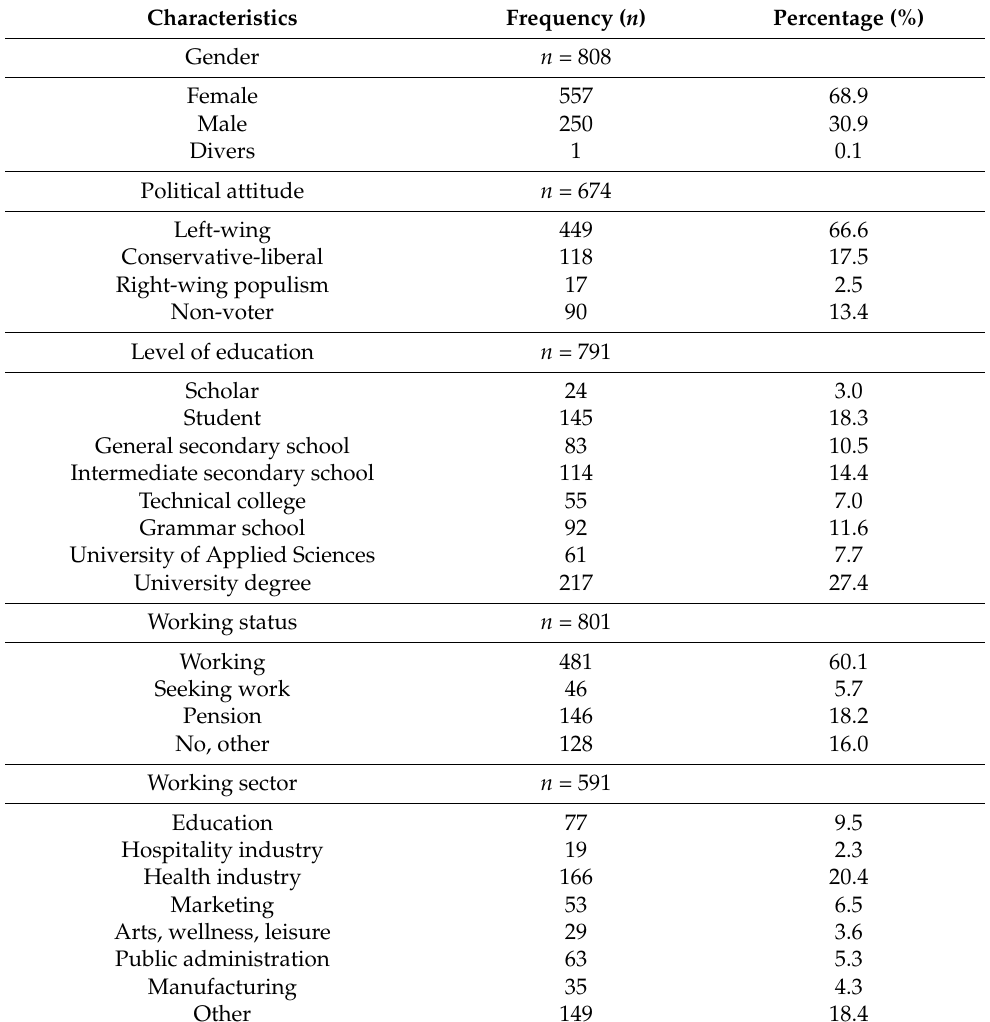
Table 1. Demographic